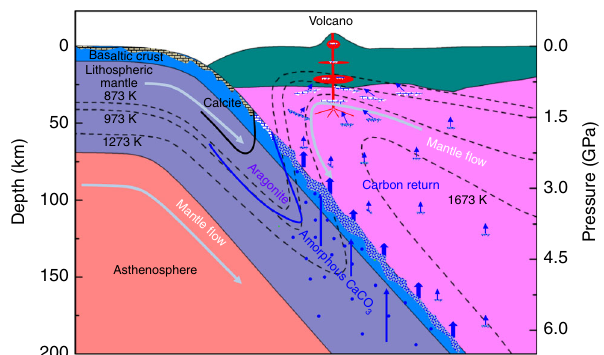
Fig. 7 Phases of CaCO 3 at upper mantle conditions and the schematic for deep carbon recycle. The geotherms follow Gerya and Yuen 58 and Penniston-Dorland et al. 59 . The blue dot and blue shaded area in subducting slabs represent the amorphous CaCO 3 and concentration area of amorphous CaCO 3 , respectively. The blue shaded particles in mantle wedge are escaped amorphous CaCO 3 through percolation. At the top of the asthenosphere in mantle wedge, the amorphous CaCO 3 would transform back to